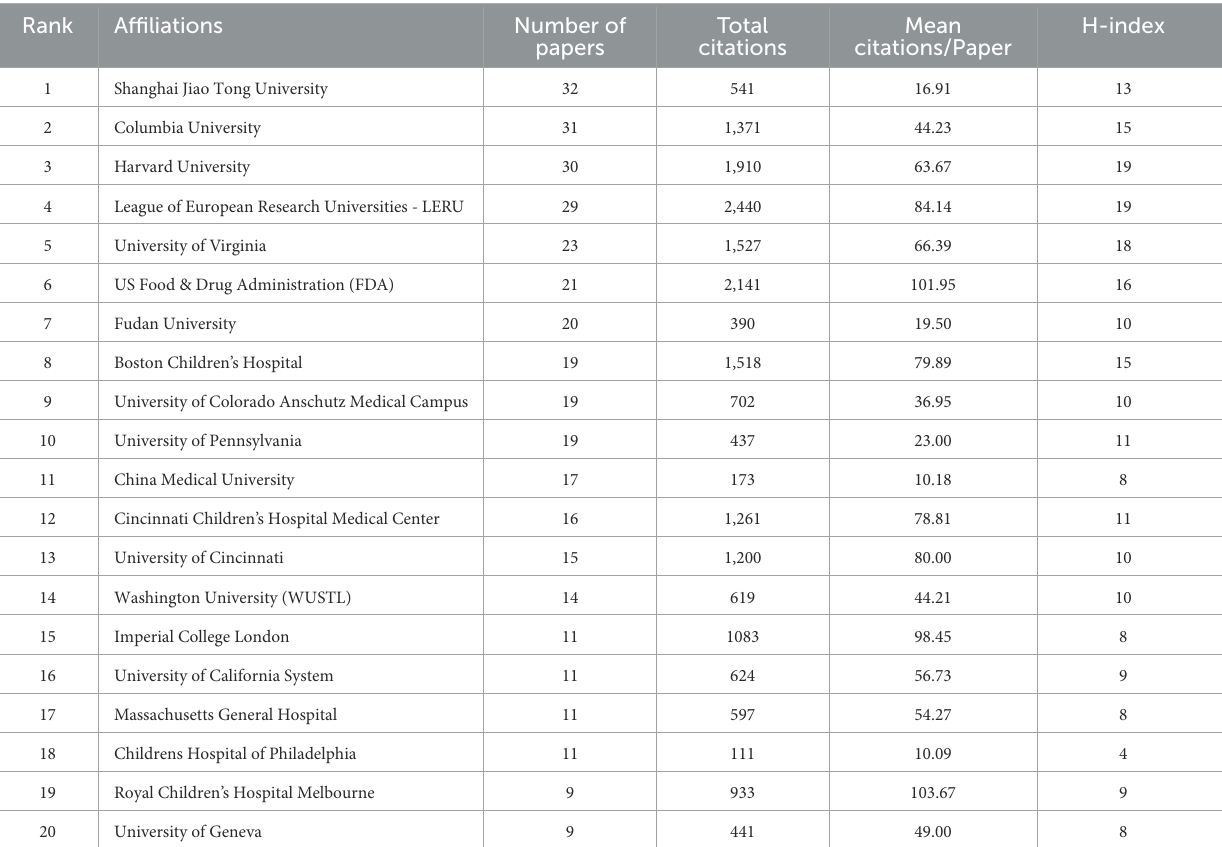
TABLE 3 The top 20 institutes with the highest number of publications the neurotoxicity of anesthesia in the developing brain.